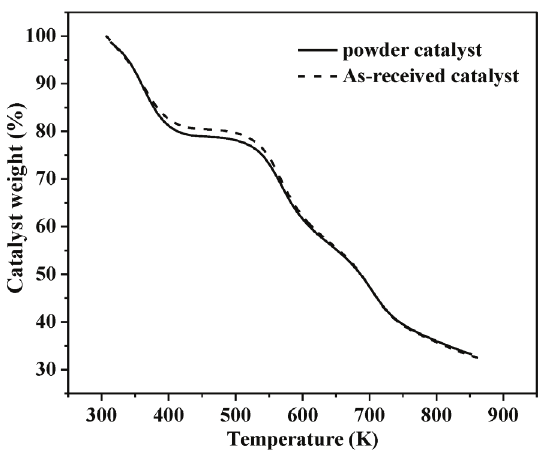
Fig. 7 – TGA of as-received and powdered Amberlyst15